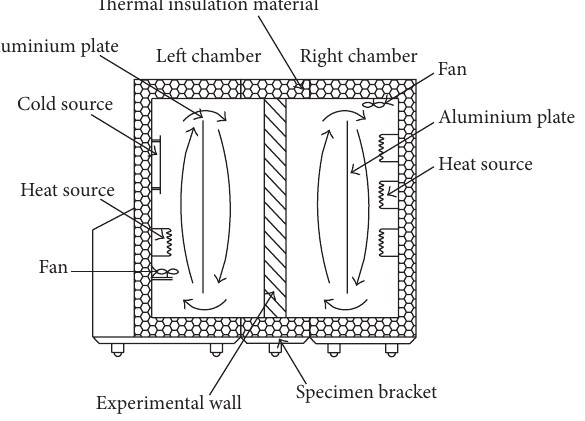
Figure 3: Experimental